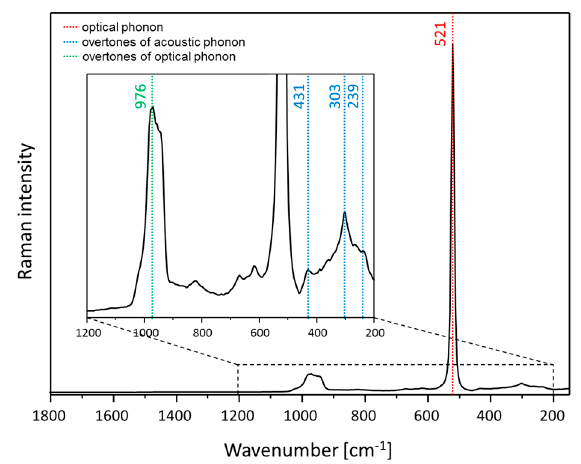
Figure 2. Raman spectrum of crystalline silicon. The Raman spectrum is dominated by the optical phonon mode at 521 cm − 1 . Overtones of optical phonons as well as acoustic phonons are marked accordingly.